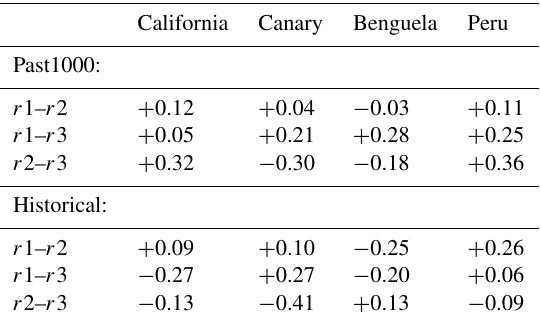
Table 2. Cross-correlation coefficients of the three simulations of Table 1. Cross-correlation coefficients of the three simulations of each ensemble ( r 1, r 2, and r 3) of the alongshore wind stress of all each ensemble ( r 1, r 2, and r 3) of the cross-coastline pressure gra- dient of all upwelling regions for the past1000 and historical simula- upwelling regions for the past1000 and historical simulations with tions with the MPI-ESM model after 30- and 10-year filters, respec- the MPI-ESM model after 30- and 10-year filters, respectively. All tively. All correlations are not statistically significant at the 95% correlations are not statistically significant at the 95% level. California Canary Benguela Peru